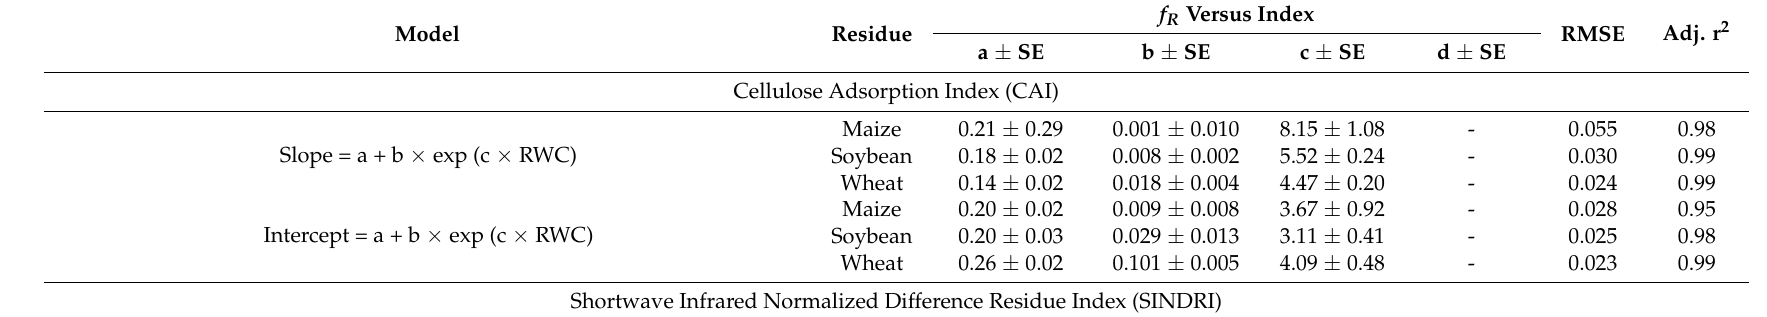
Table 4. Regression coefficients (mean ± SE), root mean square error of the estimate (RMSE) and adjusted coefficient of determination (Adj. r 2 ) of the models fitted to changes in the slope and the intercept of the percentage of residue cover ( f R ) versus the various indices studied due to the RWC of the crop residues and soil (Matawan) mixed scene from the laboratory experiment. The models are plotted in the Supplementary Materials (Figure S1). Coefficient a is the slope and intercept under dry